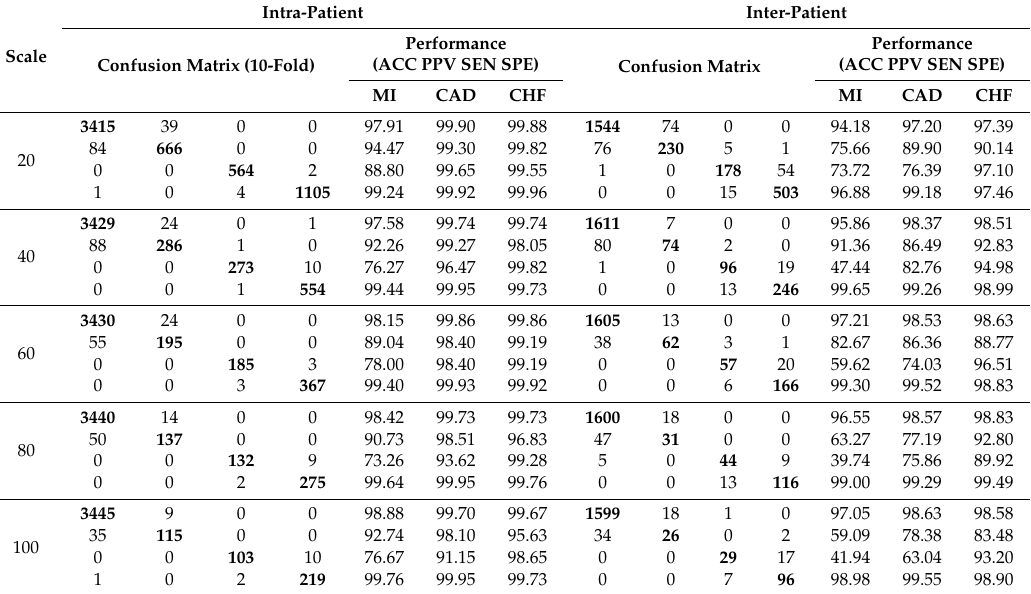
Table 13. The confusion matrix and classification performance of diseases in different scales.